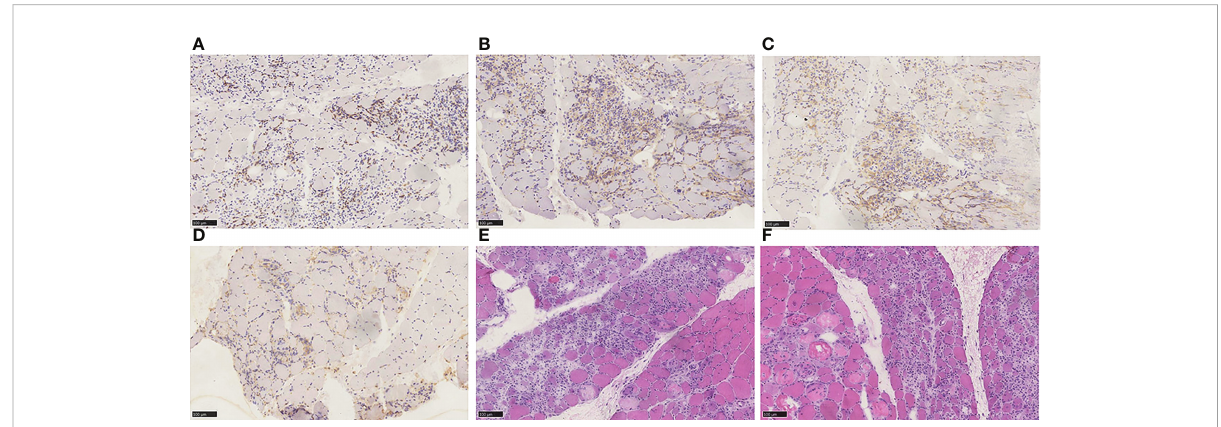
FIGURE 3 (A) Immunohistochemical staining for CD3. (B) Immunohistochemical staining for CD4. (C) Immunohistochemical staining for CD8. (D) Immunohistochemical staining for CD68. (E) HE staining. (F) HE staining. Endomysium expressed an abundance of CD68-positive cells and was also positive for CD3, CD4, and CD8 expression. The main pathological characteristics of skeletal muscle included necrosis of myo fi bers, regeneration, and in fl ammatory cell in fi ltration. Diagnosis: PD-1 mediated immune myositis with the medical